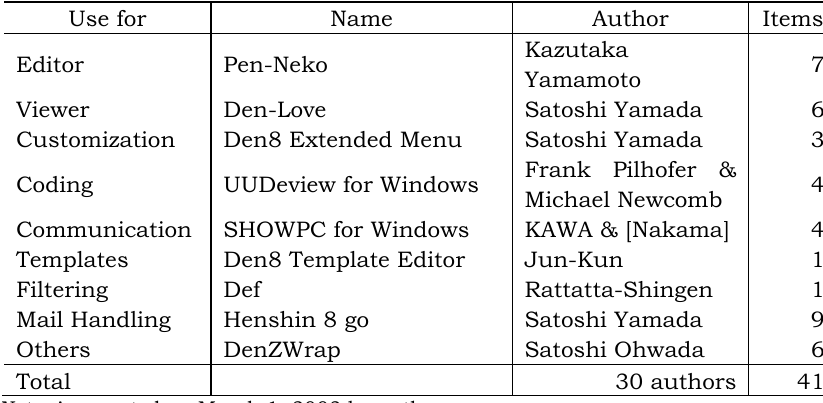
Table 1. Examples of cooperating software for Denshin 8 go Use